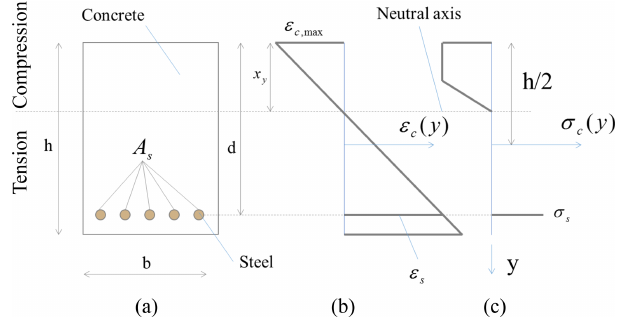
Figure 3. Cross-section of the RC beam (a) , stress (b) , and strain (c) distributions along y axis.